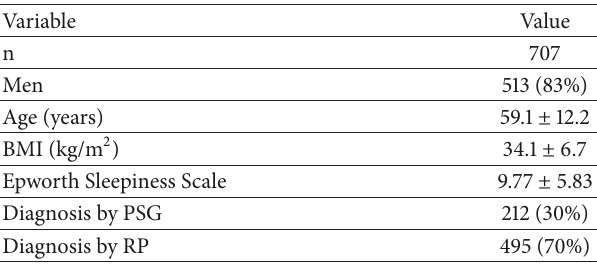
Table 1: Population related